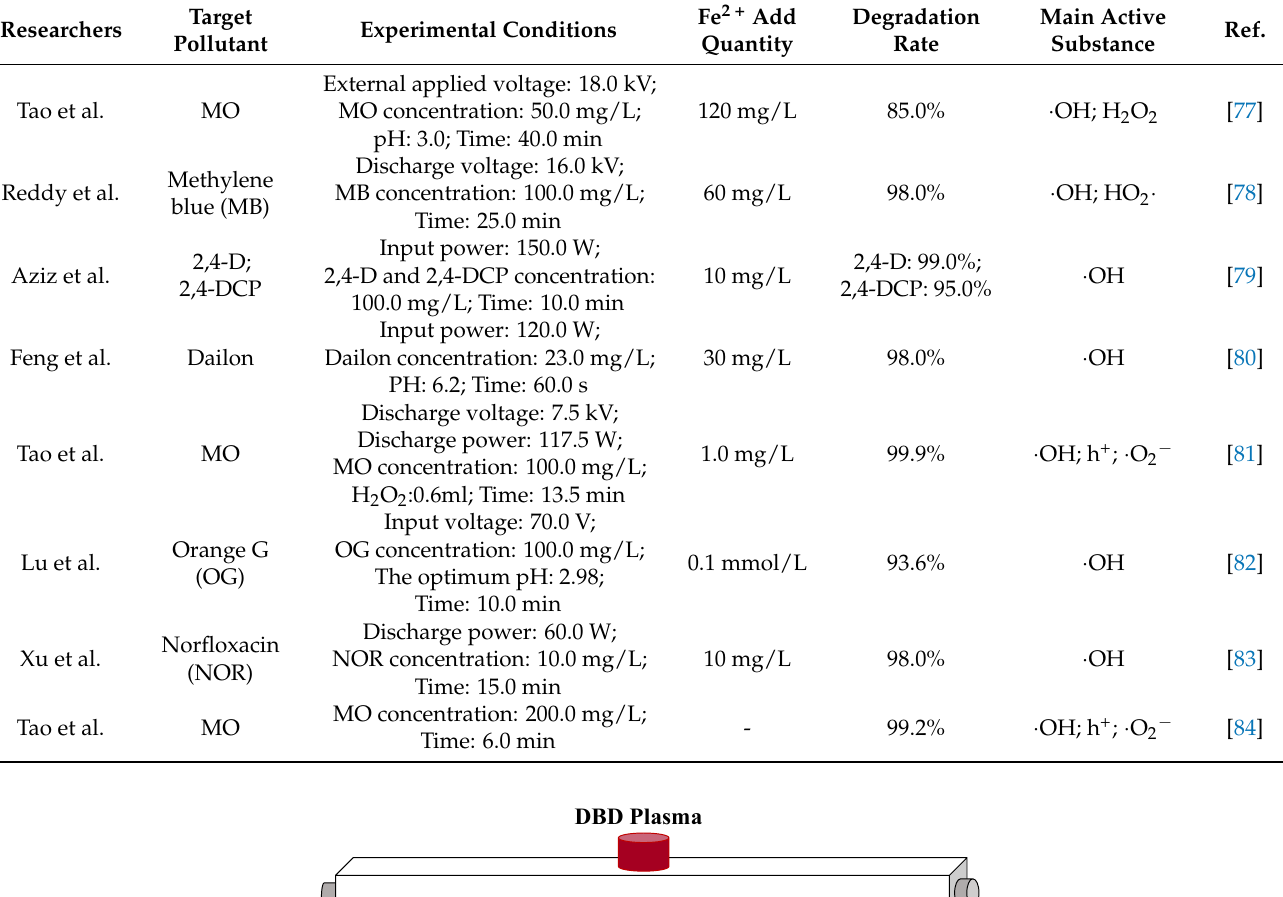
Table 3. Summary of DBD technologies with Fenton oxidation for organic wastewater removal.